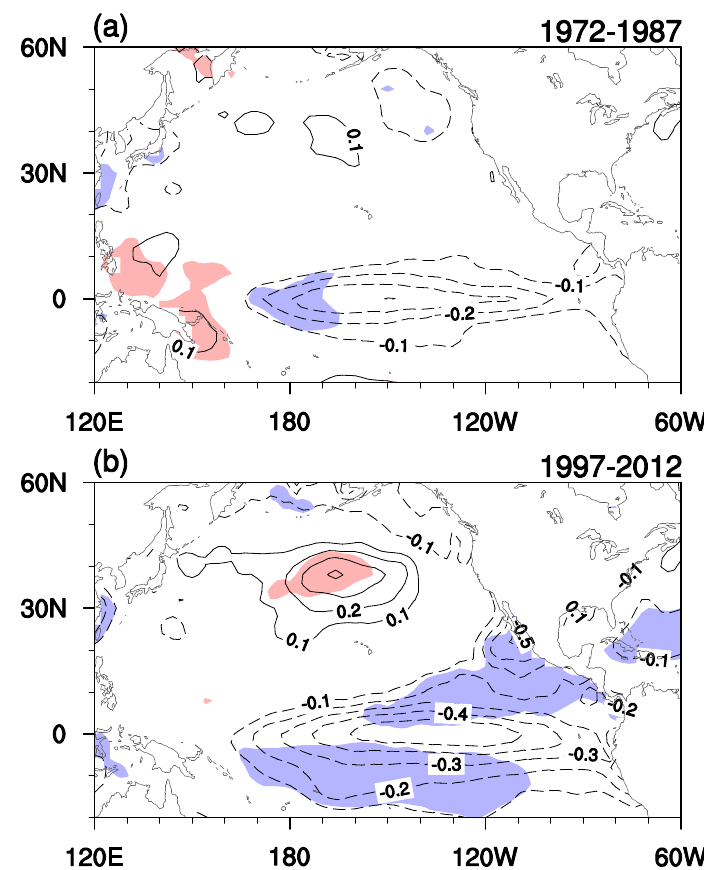
Figure 9. SST anomalies (°C) during boreal winter regressed upon the standardized PC time series of EOF1 of winter southeast Asian SAT anomalies during ( a ) 1972–1987 and ( b ) 1997–2012. Anomalies significant at the 5% level are stippled.